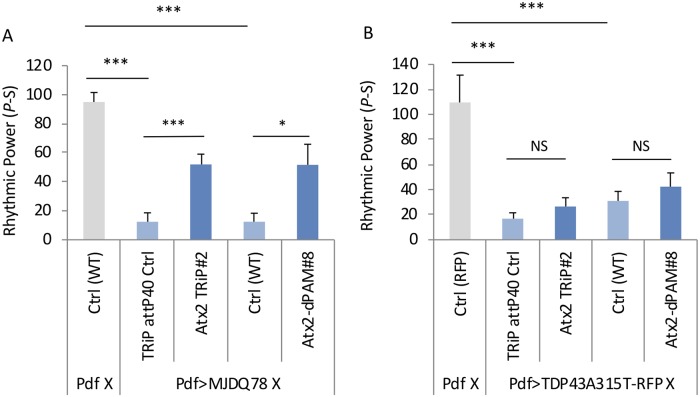
Atx2 reduction or ATX2 lacking the PAM domain rhythmic power improves behavioral rhythms in MJDQ78 but not mutant TDP43 models.A. Rhythmic power (P-S) is indicated for various genotypes including flies expressing only PdfGAL4 in the wild-type control background (Pdf X Ctrl(WT)) as well as flies expressing ATX3Q78 (MJDQ78) in PDF neurons in a TRiP RNAi library control background (MJDQ78 TRiP Ctrl#2) and expressing Atx2 RNAi lines (MJDQ78 Atx2 TRiP #2) or in wild-type control background (Ctrl) and overexpression of Atx2 lacking PAM domain (MJDQ78 Atx2-dPAM#8; n = 5–17; *p<0.05, **p<0.01, ***:p<0.005, error bars represent standard error). B. Rhythmic power (P-S) is indicated for various genotypes including flies expressing only PdfGAL4 in the RFP expressing background (Pdf X Ctrl(RFP)) as well as flies expressing mutant TDP43 (TDP43A315T) in PDF neurons in a TRiP RNAi library control background (TDP43A315T TRiP Ctrl#2) and expressing Atx2 RNAi lines (TDP43A315T Atx2 TRiP #2) or in wild-type control (Ctrl) background and overexpression of Atx2 lacking PAM domain (TDP43A315T Atx2-dPAM#8; n = 9–15; NS:not significant, *p<0.05, **p<0.01, ***:p<0.005, error bars represent standard error).